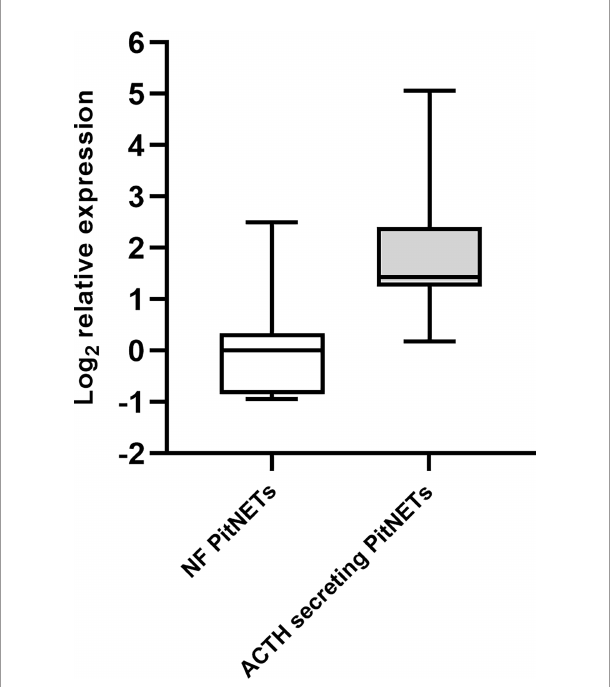
FIGURE 8 | Expression of miR-7-5p in ACTH secreting PitNET patients vs. NF-PitNET patients. The box plot represents the differences in Log 2 relative expression of miR-7-5p in ACTH secreting PitNET samples (n = 12) vs. NF- PitNET patients (n = 9). The results show that miR-7-5p is signi fi cantly upregulated in ACTH secreting PitNET patients plasma (P = 0.0013). The P value was calculated using Wilcoxon rank sum test.